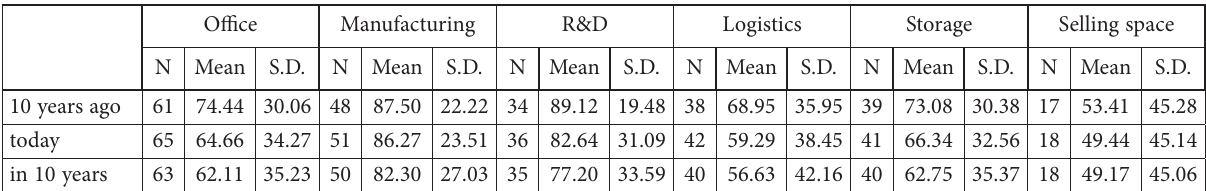
Table 5. Descriptive statistics of ownership ratios differentiated in use type and over